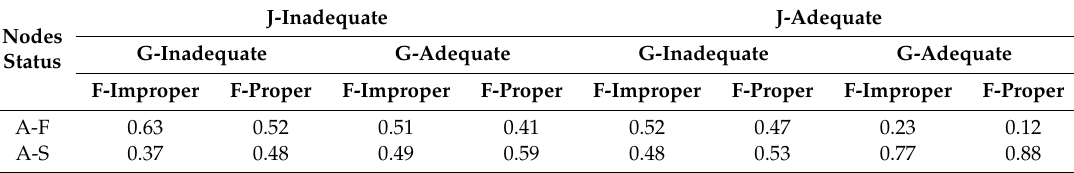
Table 2. Conditional probability tables for the “attitude problem” node.